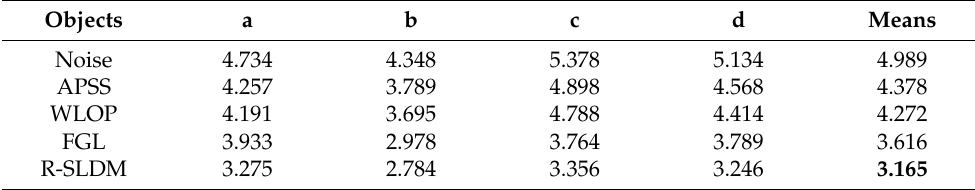
Table 6. SSIM of different denoising algorithms for four objects.